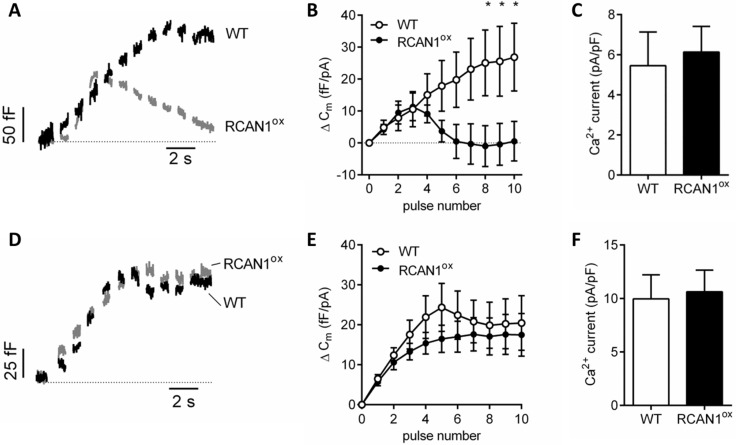
Depolarization-induced insulin secretion is reduced in RCAN1ox β-cells due to low ATP availability.(A) Perforated patch membrane capacitance trace from WT and RCAN1ox β-cells. (B) Average capacitance change at each depolarising pulse in WT (n = 14) and RCAN1ox (n = 18) β-cells, *p < 0.05. (C) Ca2+ current size from these recordings. (D) Membrane capacitance trace from WT and RCAN1ox β-cells in whole cell mode with 3mM ATP added to the pipette solution. (E) Average capacitance change at each depolarising pulse in WT (n = 13) and RCAN1ox (n = 19) β-cells. (F) Ca2+ current size from these recordings.